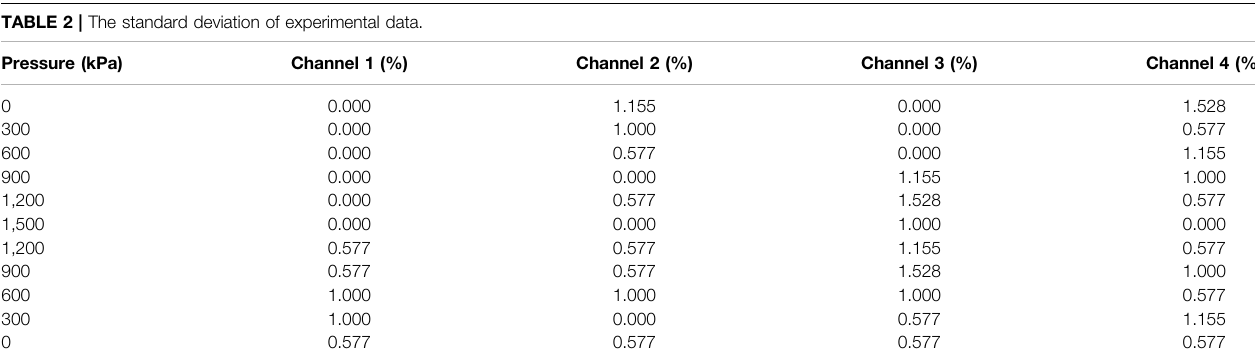
TABLE 2 | The standard deviation of experimental